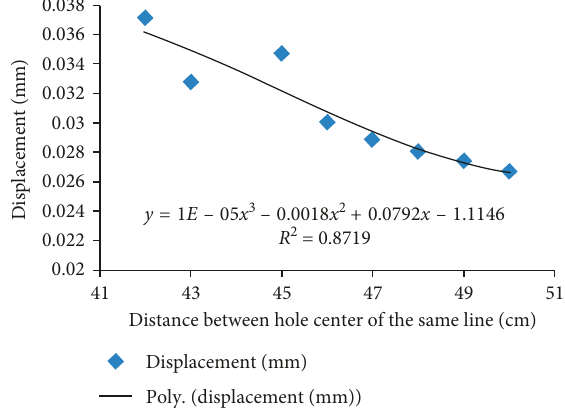
Figure 19: Maximum displacement as a function of the distance between the holes of the same line in the staggered